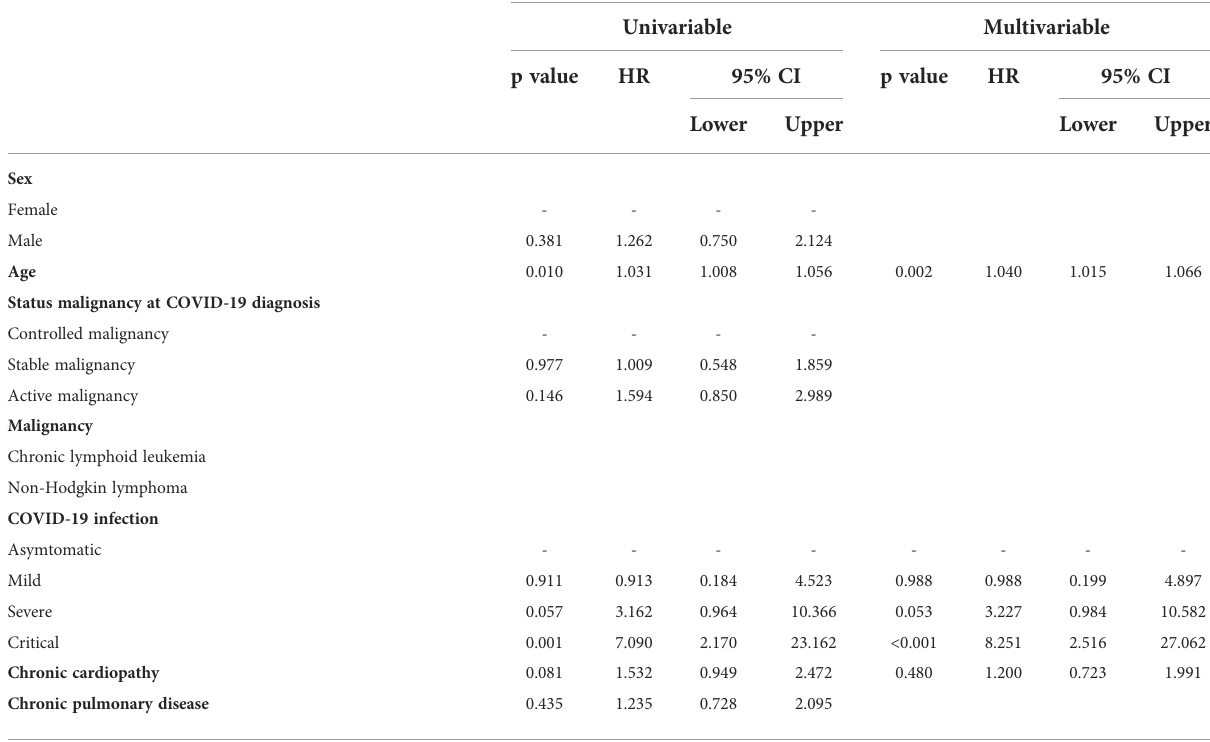
TABLE 4B Univariable and multivariable analysis of predictors of mortality in the CLL